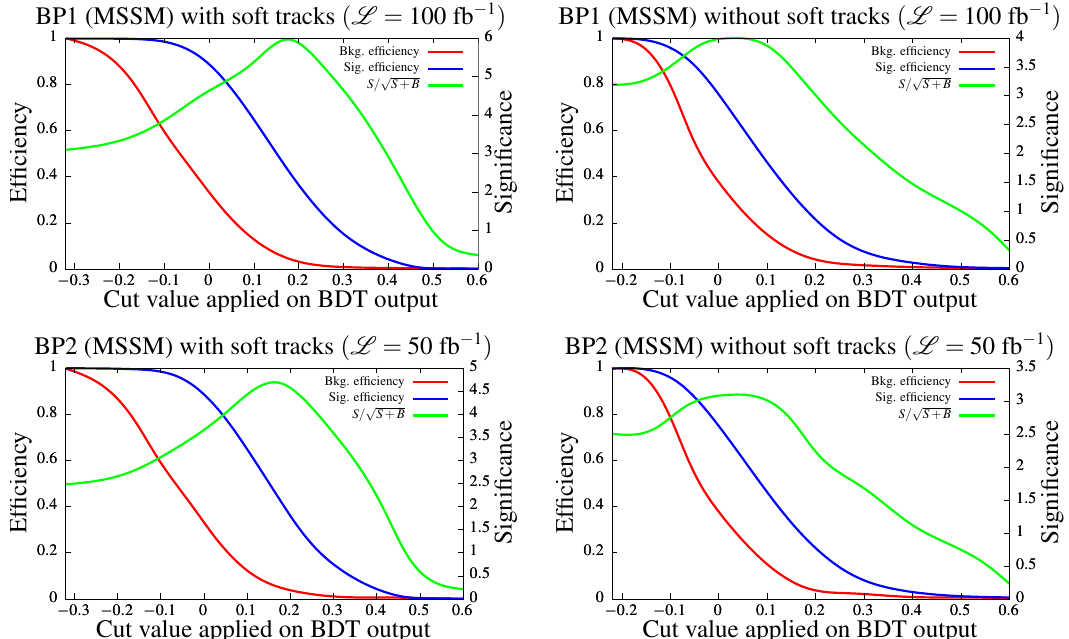
Figure 7 . We show the signal and background e(cid:14)ciencies using the BDT output for MSSM. The y -axis on the right hand side shows the signi(cid:12)cance as a function of the cut value on the BDT output for a given luminosity. The (cid:12)gures in the top (bottom) row are with 100 fb (cid:0) 1 (50 fb (cid:0) 1 ) integrated